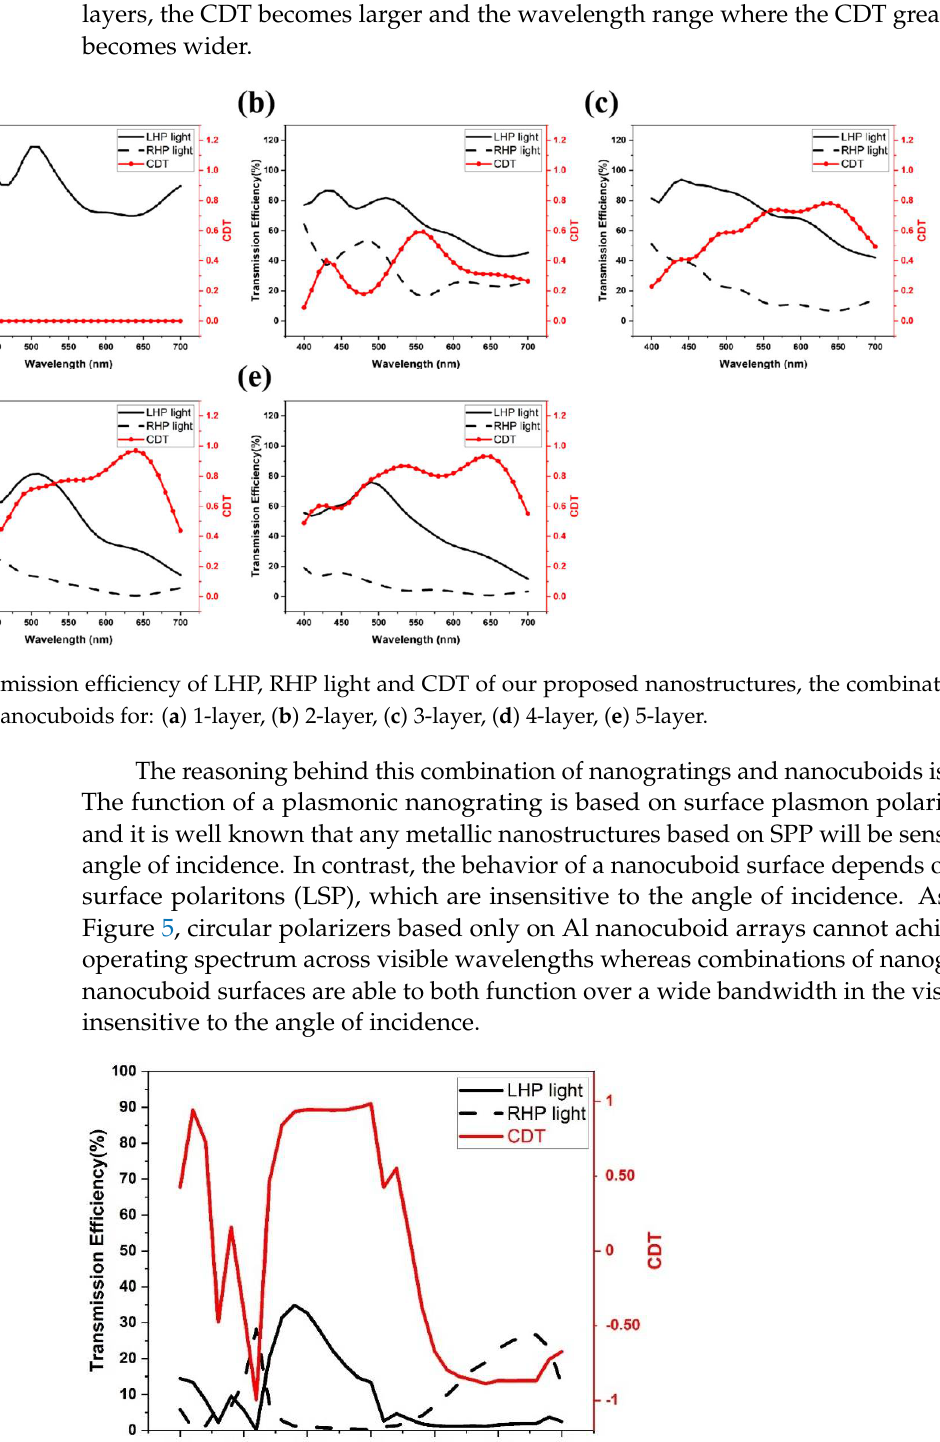
Figure 3. Black and red lines are the transmission and absorption spectra of our LHDCP under RHP incident light.